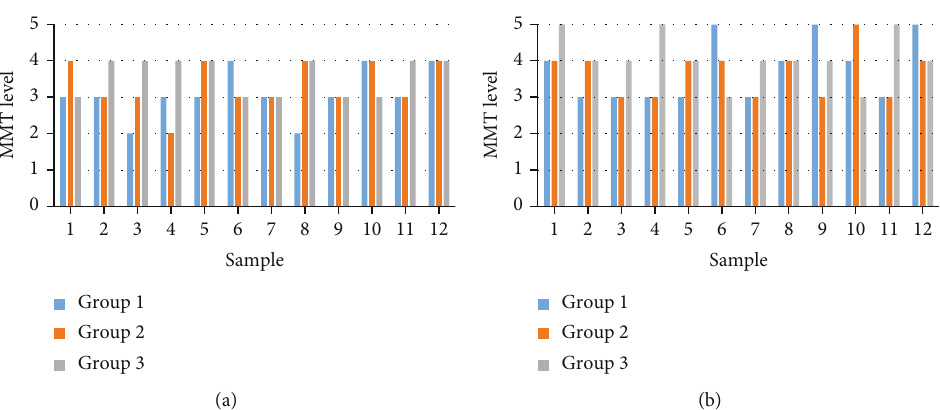
Figure 8: MMT classi fi cation before and after treatment. (a) The MMT muscle strength assessment grading of the rectus femoris before treatment in group 1, group 2, and group 3. (b) The MMT muscle strength assessment grading of the rectus femoris after treatment in group 1, group 2, and group